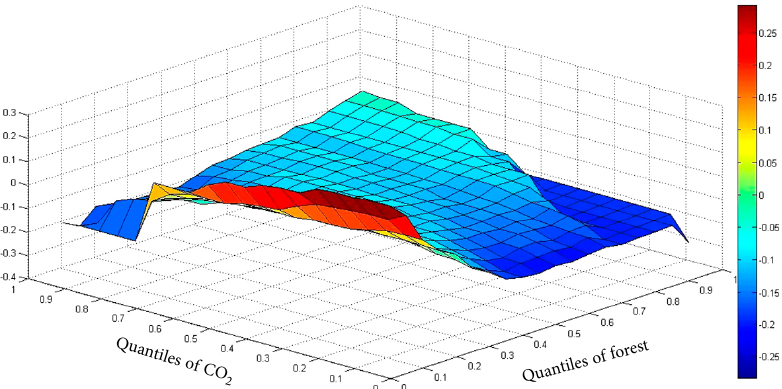
Figure 4. Quantile on quantile regression estimation for Malaysia